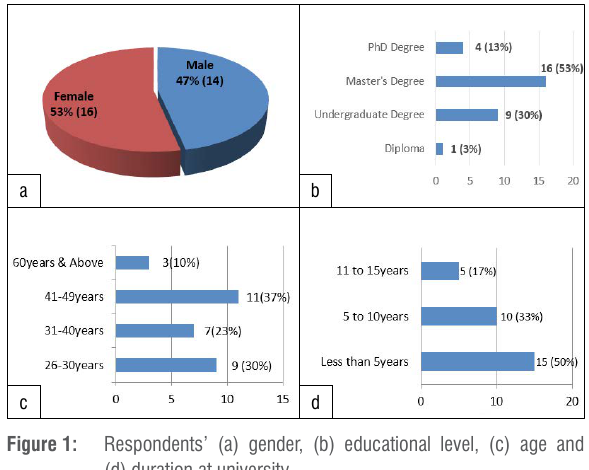
Figure 1: Respondents’ (a) gender, (b) educational level, (c) age and (d) duration at university.